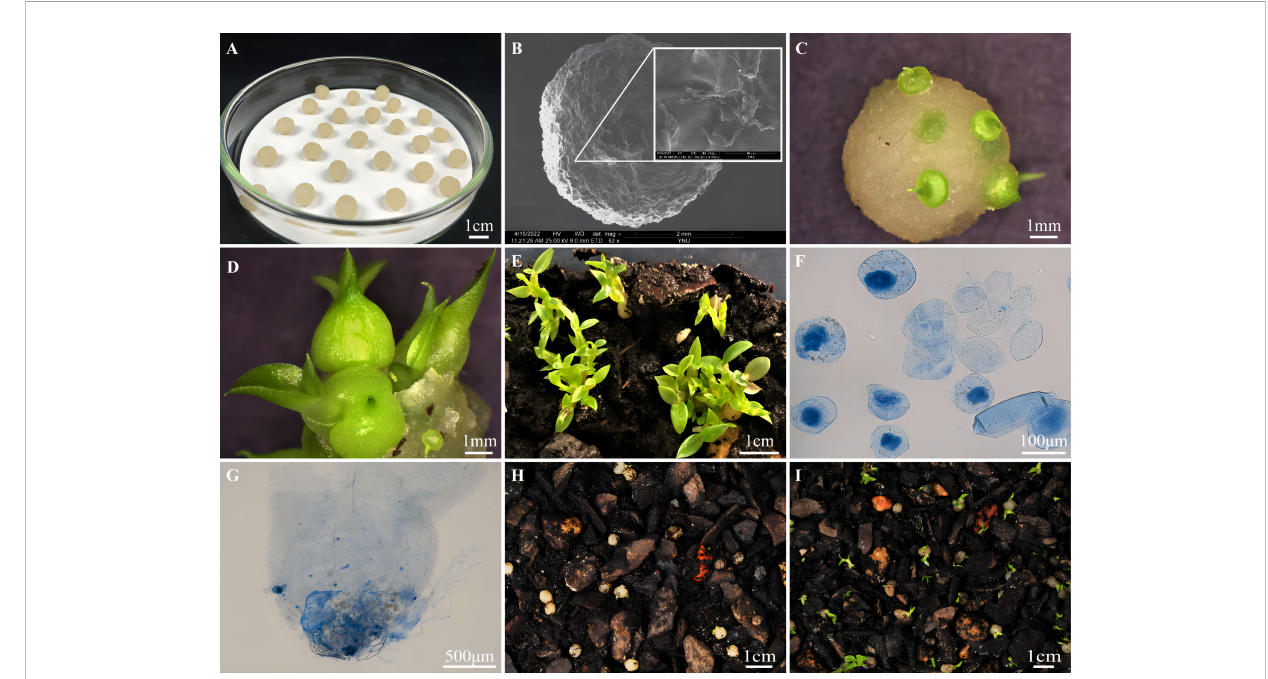
FIGURE 1 Orchid seed-fungus complexes, protocorms and seedlings produced by seed-fungus complexes at different times after sowing, and pelotons formed inside protocorms or seedling roots. (A) TP-LQ seed-fungus complexes containing seeds of Dendrobium of fi cinale and mycelia of fungal strain LQ; (B) Scanning electron micrograph of a TP-LQ seed-fungus complex and ampli fi ed box showing the fungal hyphae on the surface; (C) Protocorms produced by a TP-LQ seed-fungus complex at 30 days after sowing; (D) Seedlings produced by a TP-LQ seed-fungus complex at 60 days after sowing; (E) A large number of seedlings with 3-5 leaves and roots produced by TP-LQ seed-fungus complexes at 90 days after sowing; (F) Pelotons formed inside seedling roots in TP-LQ seed-fungus complexes at 90 days after sowing; (G) Pelotons and fungal hyphae at the basal cells of a protocorm produced by TP-LQ seed-fungus complexes at 90 days after sowing; (H) Protocorms produced by TP-SSCDO-5 seed-fungus complexes at 90 days after sowing; (I) Seedlings produced by TP-JM seed-fungus complexes at 90 days after